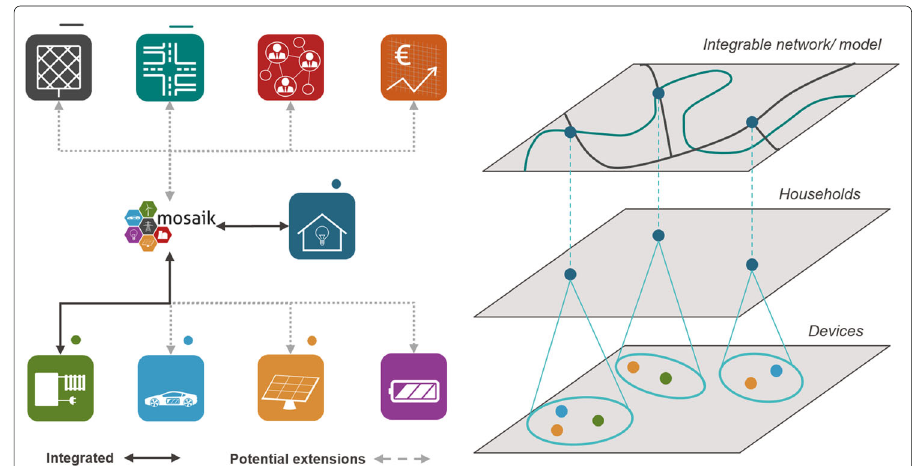
Fig. 1 Overview of the co-simulation design and potential extensions